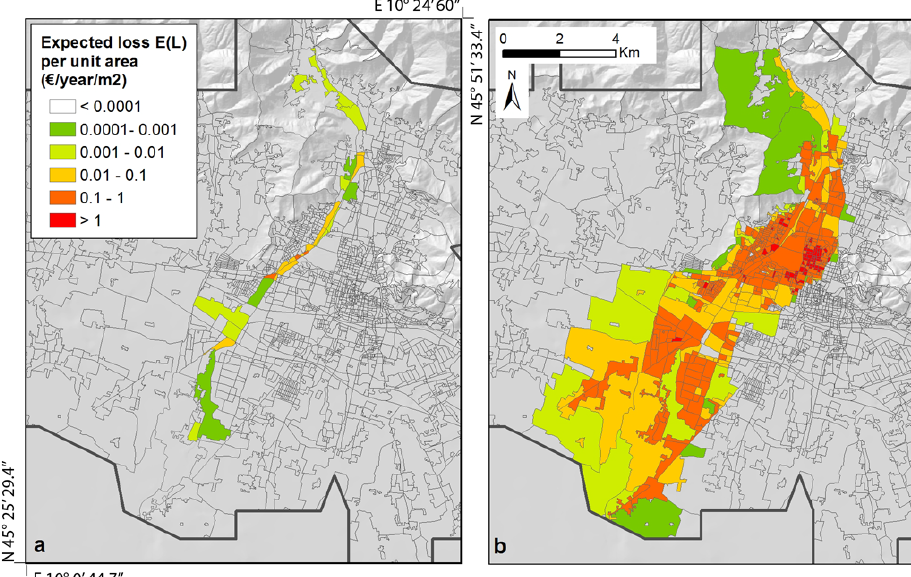
Fig. 5. Flood risk values obtained by means of FOSM and USACE (2003) vulnerability model for flood scenarios with return period (a) 200yr; (b) 500yr. Table 3. Expected losses E(L) for flood scenarios, vulnerability model from USACE (2003): range of values for all the census parcels, and total on the study area for return time T r 200 and 500yr. Comparison of the three methods: Monte-Carlo-Simulation, First Order Second Moment, and point estimate. Monte-Carlo-Simulation FOSM Point estimate Range of T r 200yr